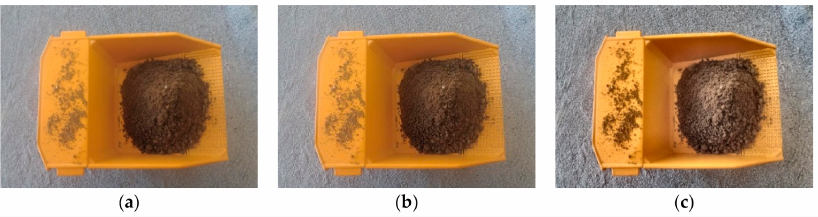
Figure 7. Images after preprocessing: ( a ) Original image; ( b ) Pixel value reduction; ( c ) Histogram